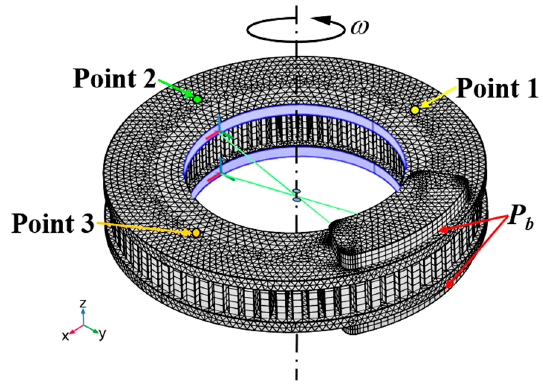
Figure 4. Finite-element model of ventilated brake disc and brake pad.